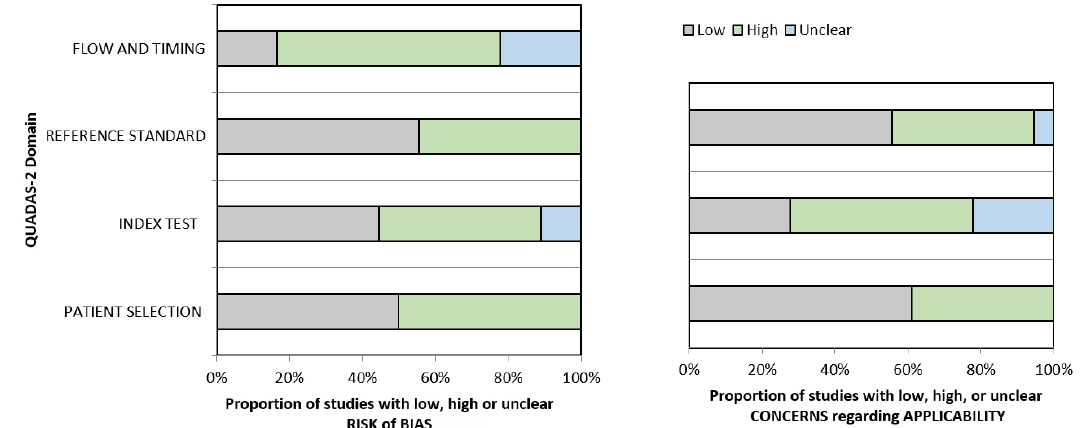
Figure 2. Grouped bar graphs of risk of bias and applicability concerns for the included diagnosis-related studies using QUADAS-2